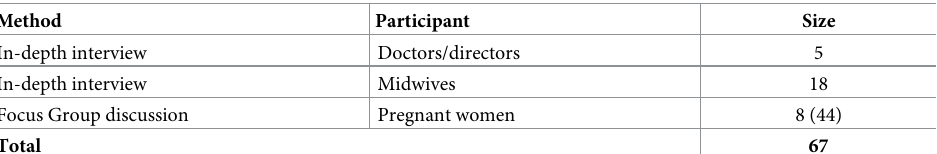
Table 7. Distribution of qualitative study